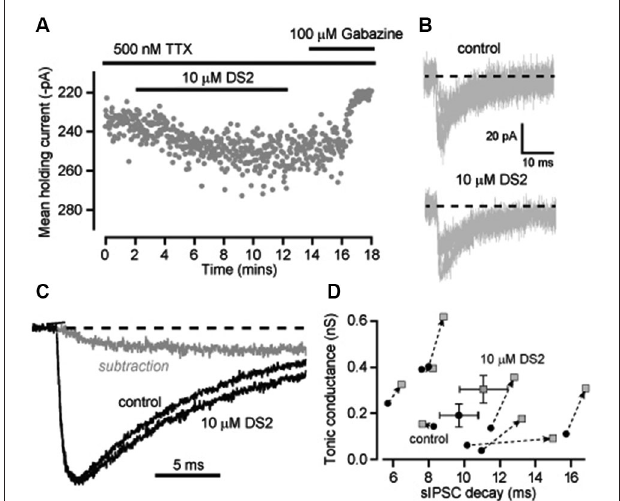
FIGURE 4 | Enhancement of the tonic conductance by DS2 in layer II/III cortical neurons is attenuated in conditions of reduced GABA release whilst still significantly increasing the IPSC decay . (A) Plot of the average holding current calculated every 1 s from consecutive 100 ms epochs (grey circles) recorded from a cortical neuron during a 10 µ M DS2 application followed by application of 100 µ M gabazine in the continuous presence of the sodium channel blocker TTX (500 nM). (B) Representative mIPSCs recorded in control conditions and after DS2 application from a single cell. Dashed line indicates the normalised baseline. (C) Representative trace of average IPSCs recorded in the presence of TTX before and after DS2 application and the subtracted waveform (grey line). Dashed line indicates the normalized baseline. (D) Scatter plot of the average tonic conductance and the IPSC decay before and after DS2 application (dotted arrow) for each cell examined (grey circles) and also the average data for all cells (mean ± SEM, n =